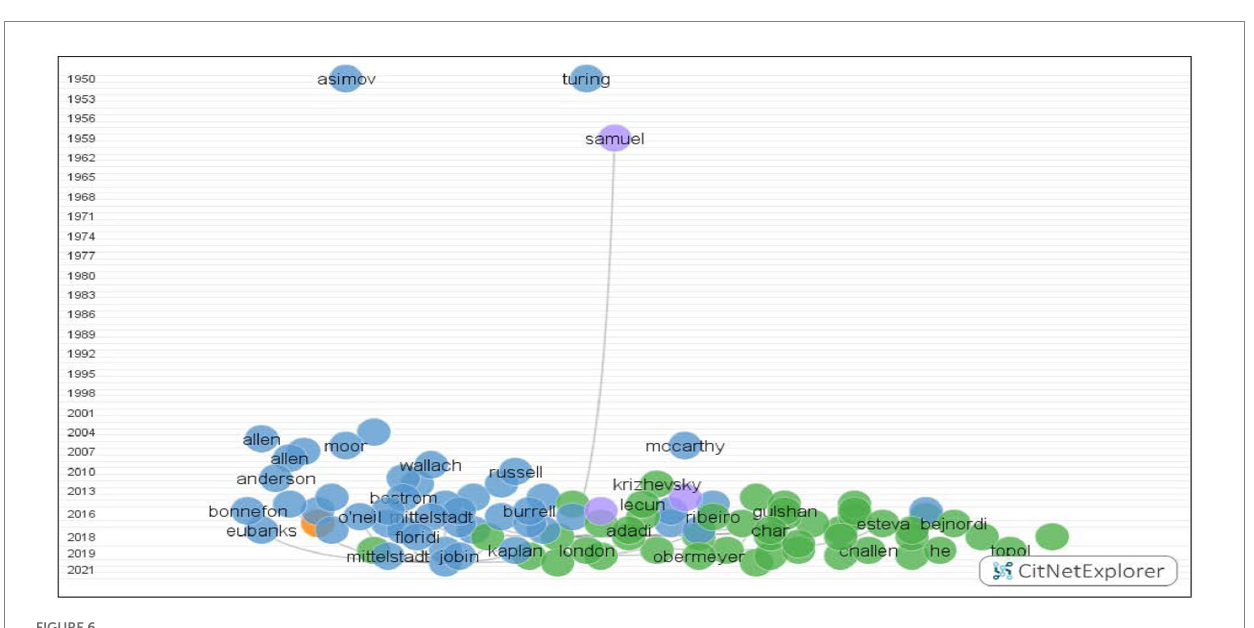
the first two groups, leading to summarized themes, i.e., the essence and principles of ethics of AI used in education.